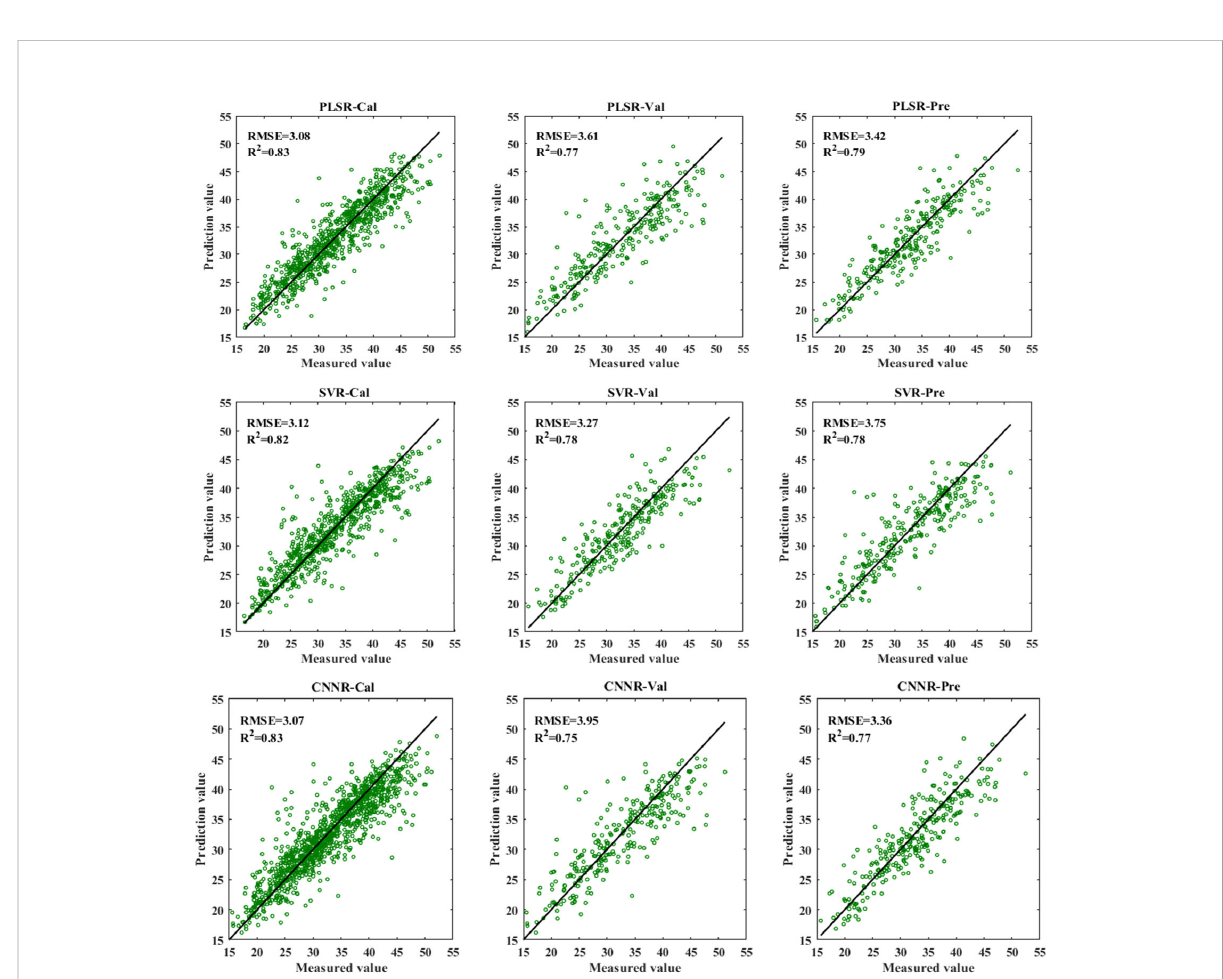
FIGURE 7 The results of PLSR, SVR, CNNR models based on full spectra for LNC